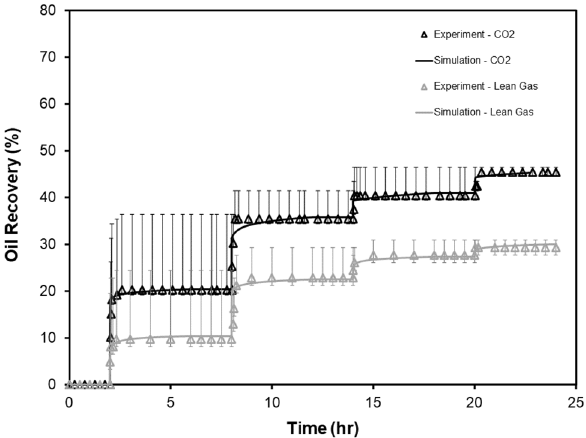
Figure 5. Comparison between experimental and simulated oil recovery as a function of time for the CO 2 and lean gas HNP cycles (#1 to #4). Note the last two cycles (#5 and #6; see Supplementary Appendix S3 online) for CO 2 HNP are not simulated because (1) they were not simulated before the experiments and (2) they did not result in significant additional recovery. CO 2 data are adopted from Song et al. 28 while lean gas data are generated in this